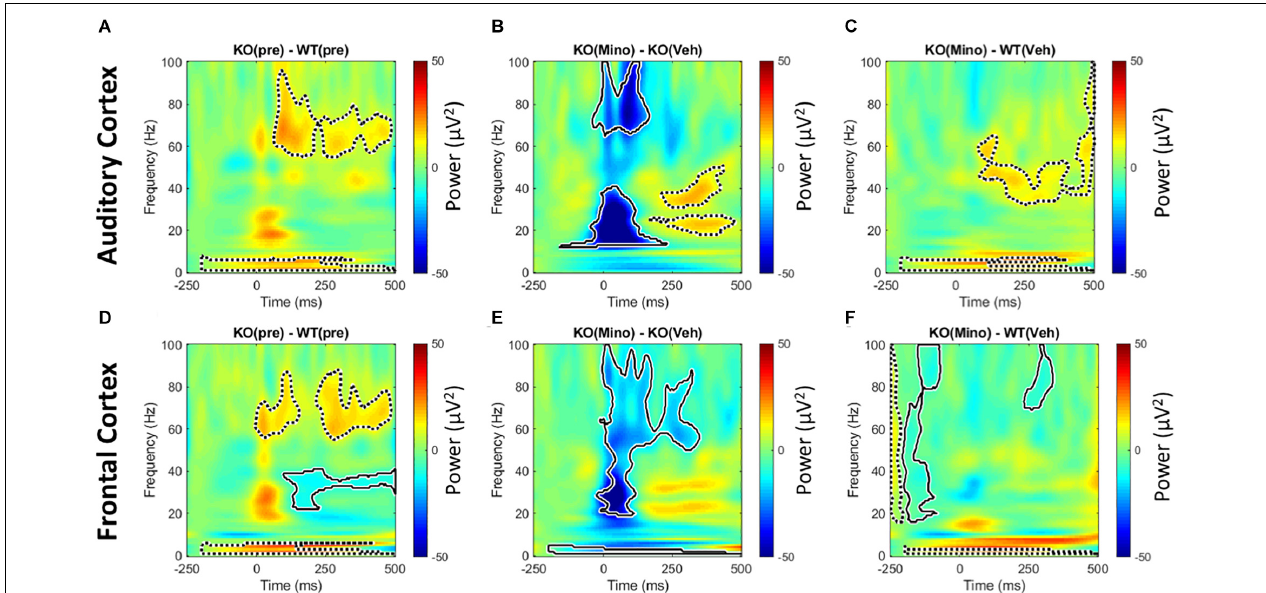
FIGURE 7 | Minocycline reduces sound-induced gamma power in Fmr1 KO mice. Trains of 100 ms duration broad band noise were used to generate event related potentials (200 repetitions) for time × frequency analyses. After correcting for baseline (–250 ms through –150 ms) single trial power was averaged over all trials. This allows for the analysis of power that is normalized to individual animal baselines. In the pre-drug condition, Fmr1 KO mice showed increased on-going power after the auditory stimulus in the delta and high gamma range in both AC and FC (A,D) . In addition, the FC showed a significant reduction in power the beta to low gamma frequency range (D) . Minocycline treatment significantly reduced onset power in Fmr1 KO animals over vehicle treatment in both FC and AC (B,E) , but also increased power in the AC in two distinct bands at ∼ 20 and ∼ 40 Hz that occurred well after sound onset. Finally, comparing minocycline treated Fmr1 KO mice to vehicle-treated WT group, reveals a shift in power in AC from high gamma in (A) , to low gamma in (C) . Additionally in the FC, ongoing gamma power and modulation of beta – low gamma power in (D) are significantly reduced (F)